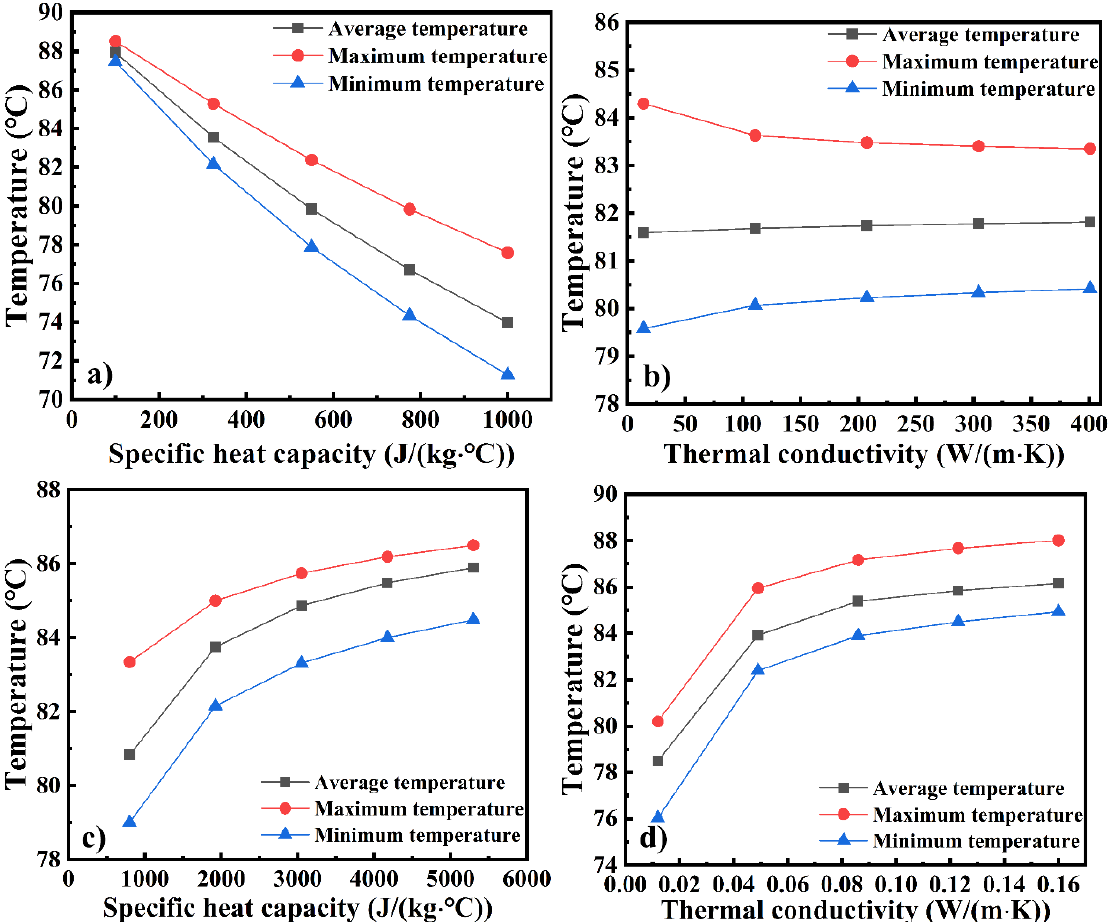
Figure 12. The average, maximum, and minimum temperature of the mold plate as functions of ( a ) specific heat of the mold, ( b ) thermal conductivity of the mold, ( c ) specific heat of the fluid, and ( d ) thermal conductivity of the fluid.